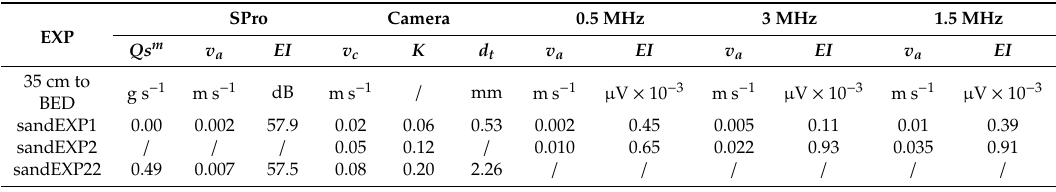
Table 4. Average bedload data measured in the NTNU flume. Qs m is the sediment transport rate measured using the bedload trap.